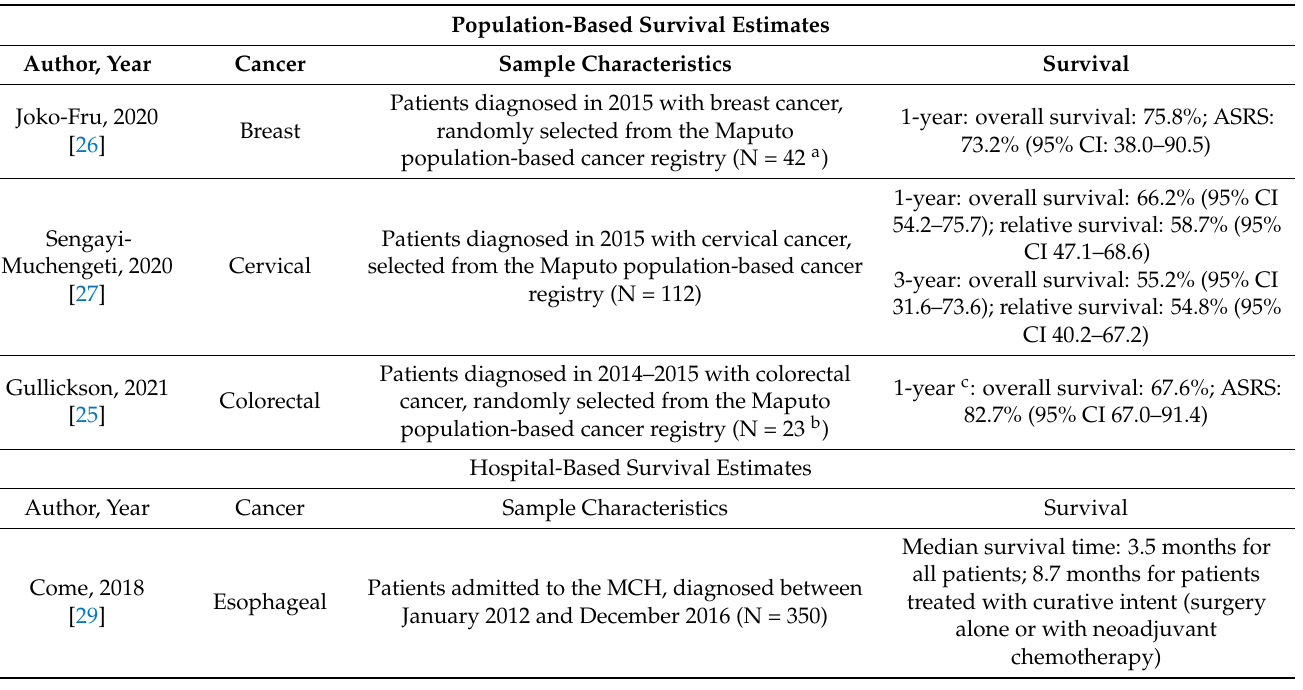
Table 1. Cancer survival data estimates from